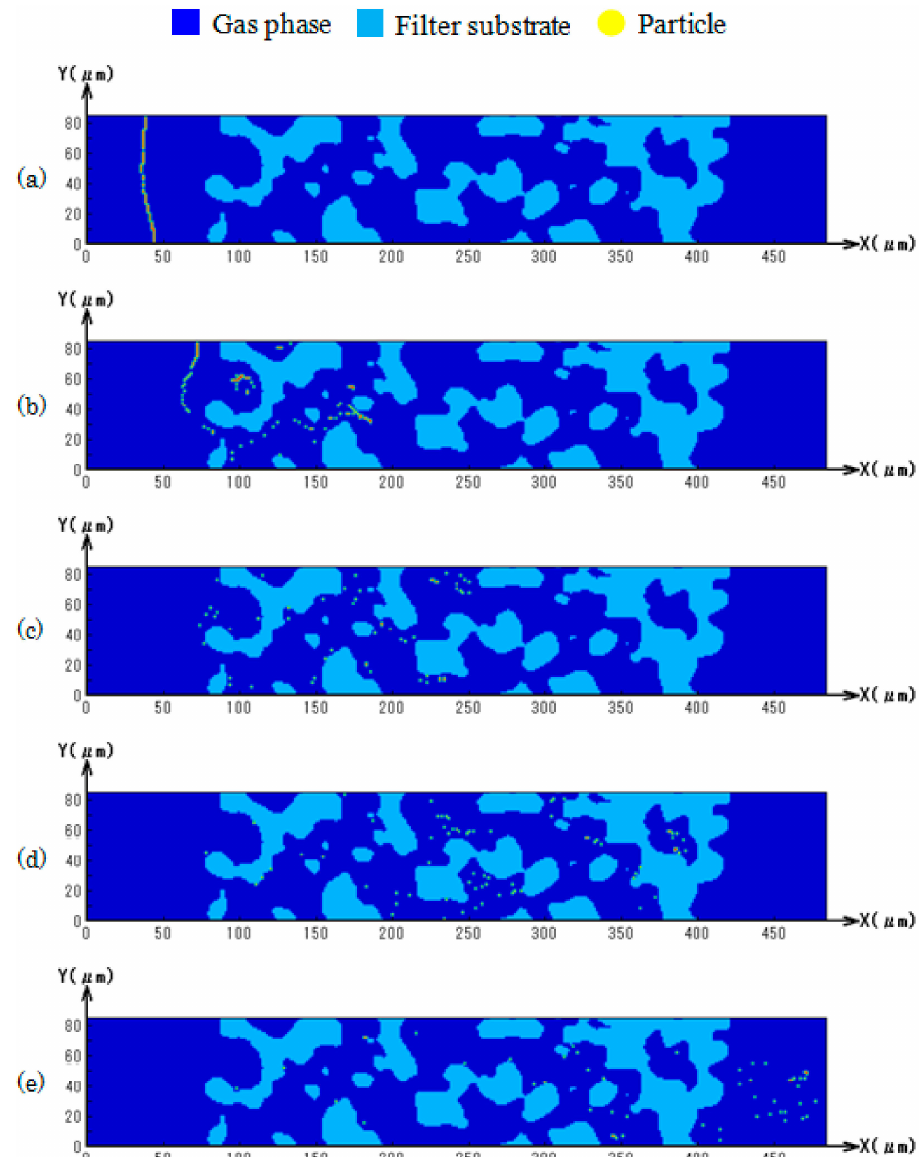
Figure 9. Particle position transported by convection in sample 1 at t = ( a ) 4 ms, ( b ) 7 ms, ( c ) 11 ms, ( d ) 14 ms, ( e ) 21